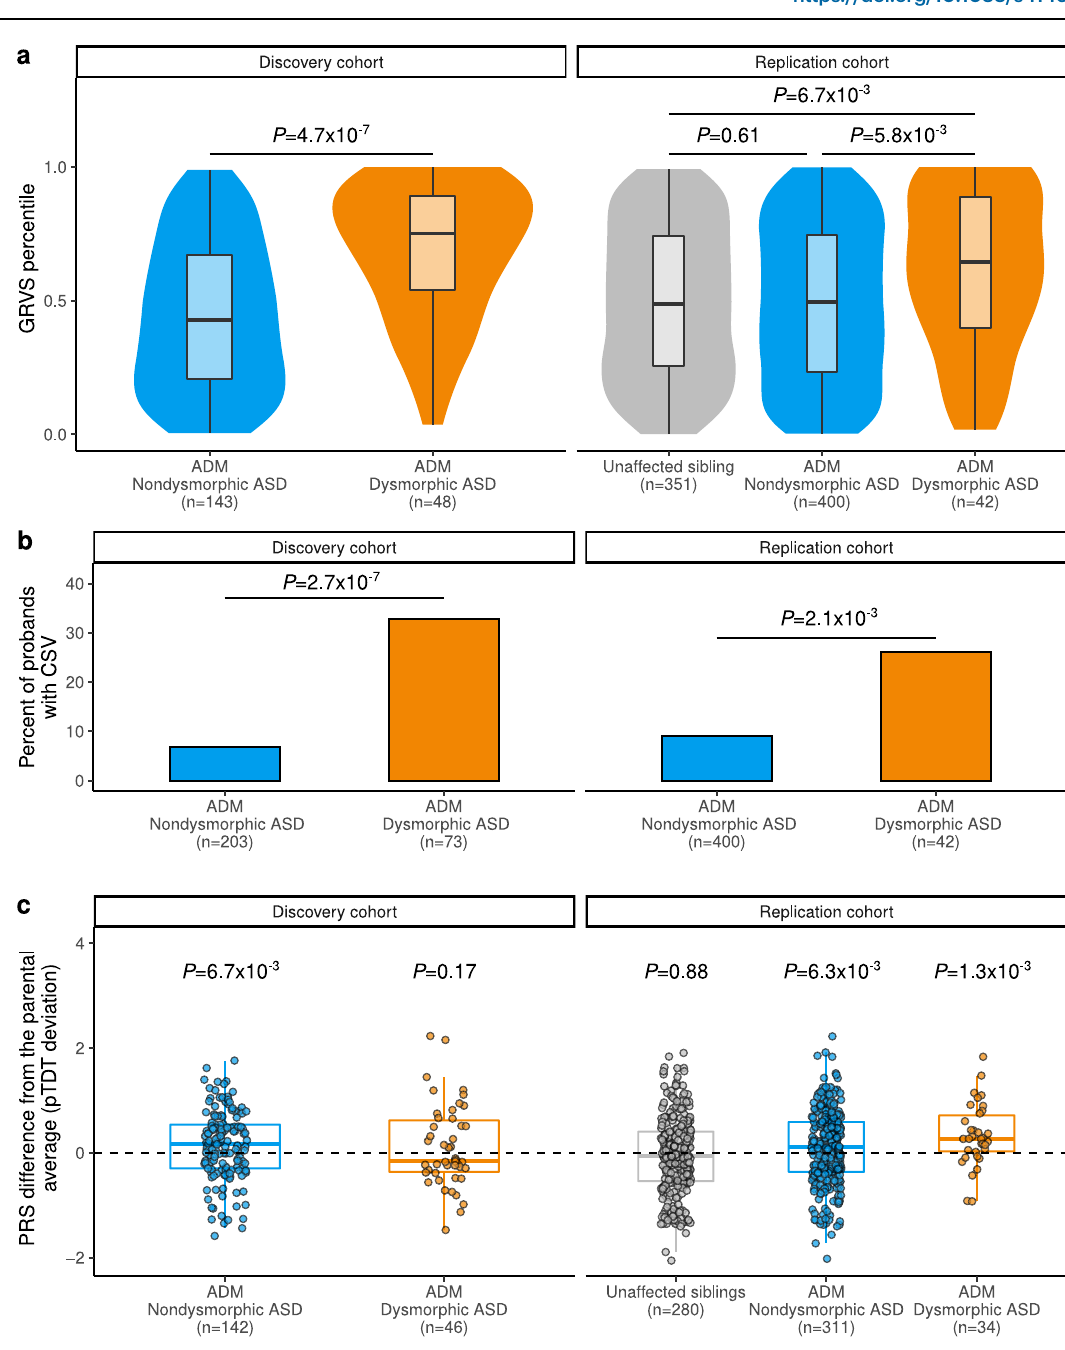
ofsubjects. P valuesforeachsubgroupindicatetheprobabilitythatthemeanofthe pTDT deviation distribution is not greater than zero (one-sided, Welch ’ s t -test), as depicted by the dotted line. The fi nding of no signi fi cant overtransmission in dysmorphic ASD did not replicate in SSC, which might be due to lack of statistical power (i.e., at least 100 dysmorphic samples are needed to achieve 80% power if PRS explains 2.45% of phenotypic variance 11 ) and/or ascertainment differences betweenthediscoveryandreplicationcohorts.Thediscoverycohortincludeddata about major congenital anomalies in morphologic classi fi cation, whereas the replication cohort did not. While our discovery cohort was population-based, the Simons Simplex Collection excluded probands with medically signi fi cant perinatal diseases, severe neurological de fi cits, and certain genetic syndromes 32 . This likely decreased the proportion of probands with excess MPAs and birth defects, potentiallyleadingtoalowerburdenofcommonASD-associatedvariants 88 .Source data are provided as a Source Data fi